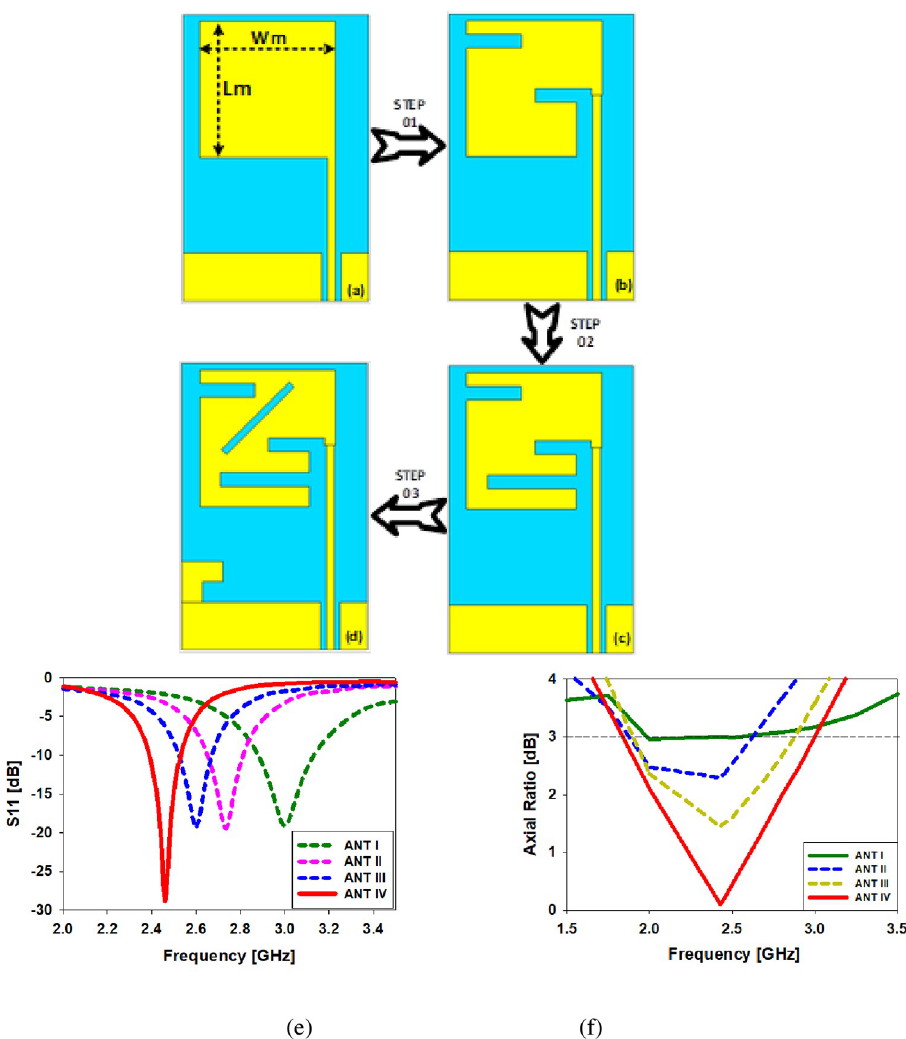
Fig 3. The antenna design process begins with the rectangular monopole, followed by a slotted monopole, a modified slotted monopole, and a modified slotted monopole with a ground plane (ANT IV), (e) S11 simulation findings, (f) axial ratio comparison in